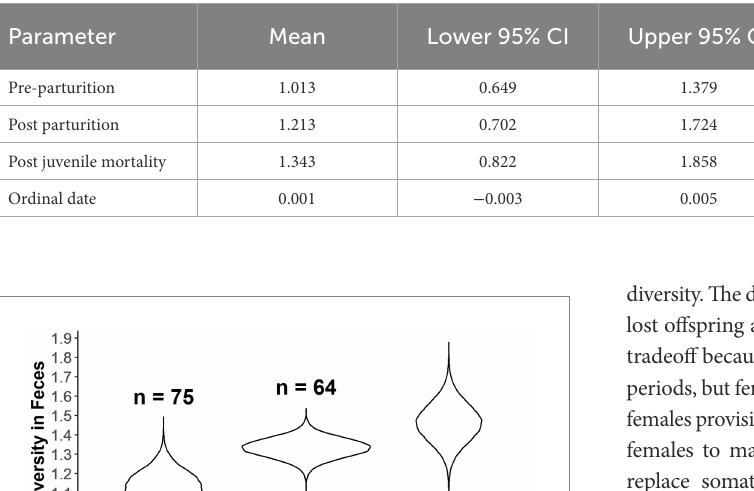
TABLE 4 Results from the ANCOVA in a Bayesian hierarchical framework testing the effect of Ordinal date and parturition groups (i.e., Pre- parturition, post parturition, and post juvenile mortality) on the diversity in the diets of desert bighorn sheep at Lone Mountain, Nevada (2016–2018).